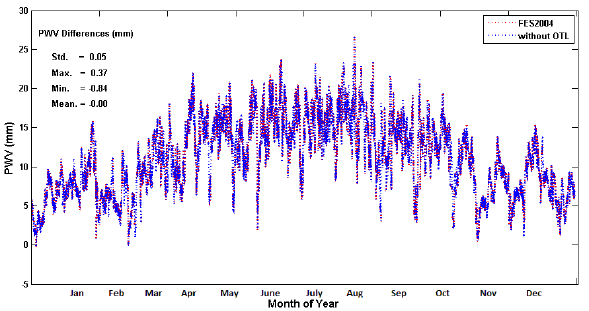
Figure 6. GNSS-estimated PWV time series at DIYB station